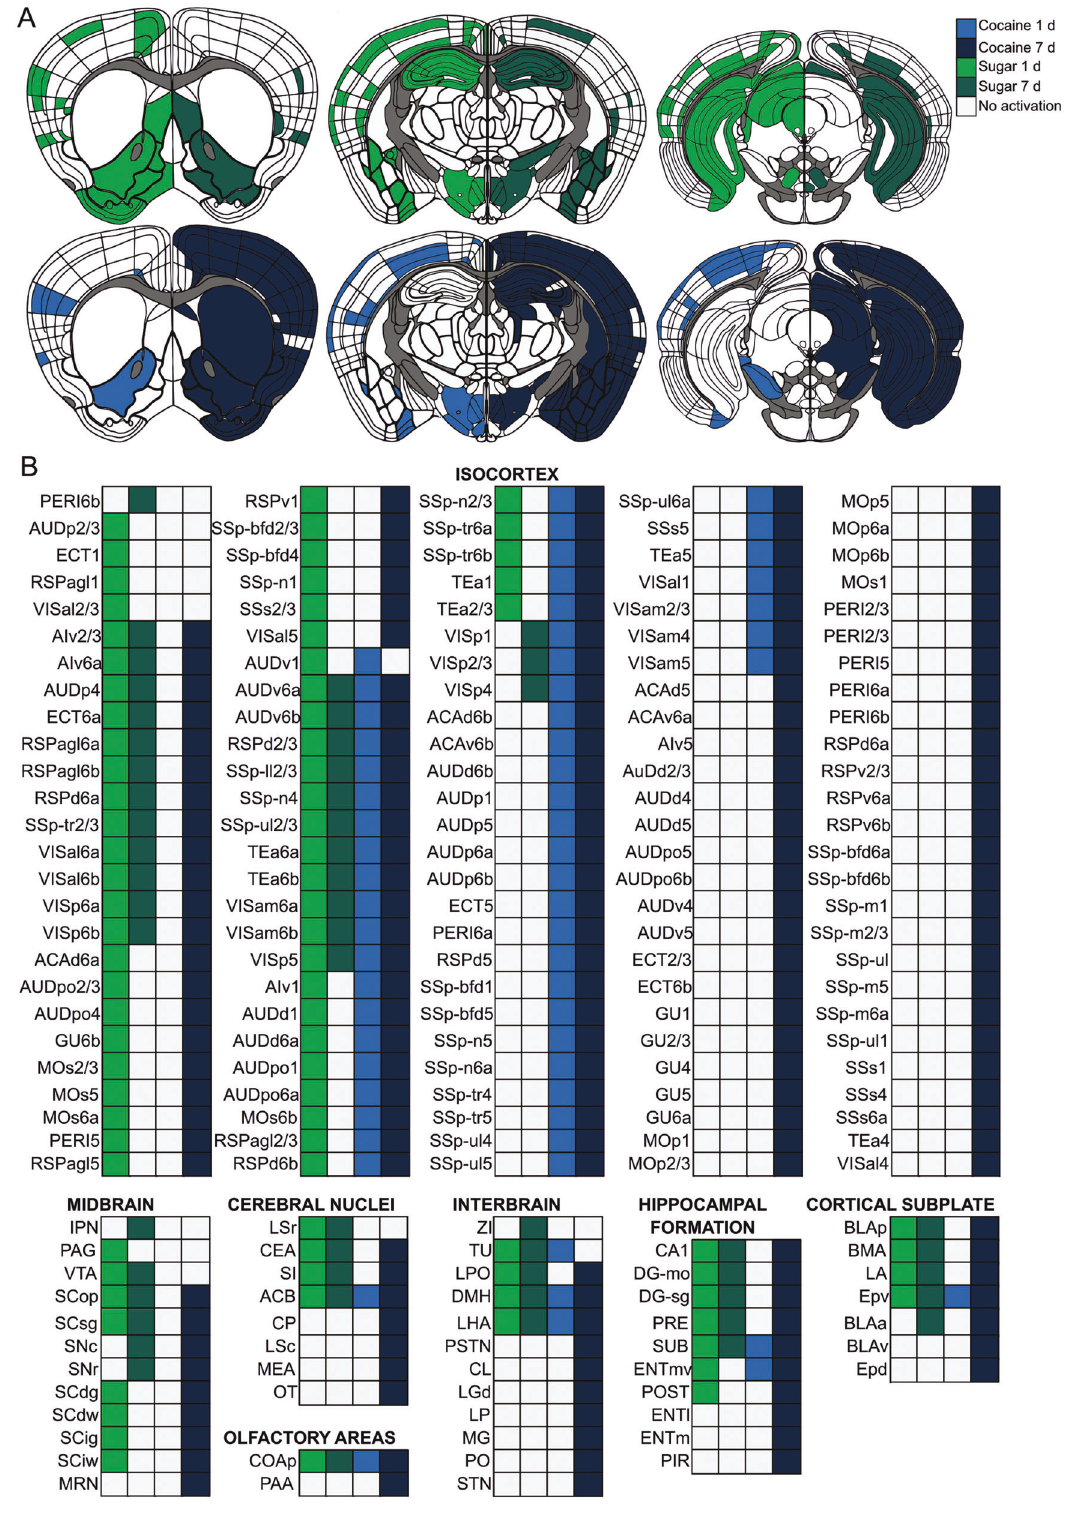
Fig. 2 c-Fos expression mapped in the reward system of the brain. A Brain schemes based on Allen Brain Atlas with colored structures with signi fi cantly elevated c-Fos levels. B List of brain structures from schemes in A with signi fi cantly elevated c-Fos levels. N Water = 7, N Sugar 1 d = 5, N Sugar 7 d = 7, N Saline = 7, N Cocaine 1 d = 6, N Cocaine 7 d =